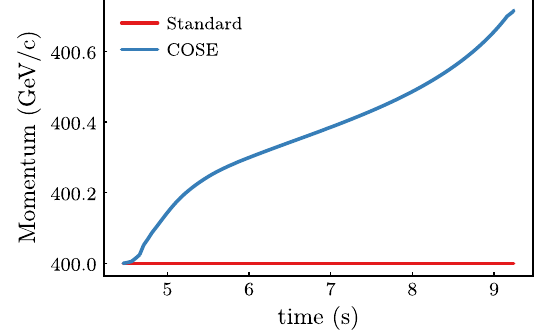
FIG. 7. Variation of amplitude and phase of virtual sextupole during spill with COSE.